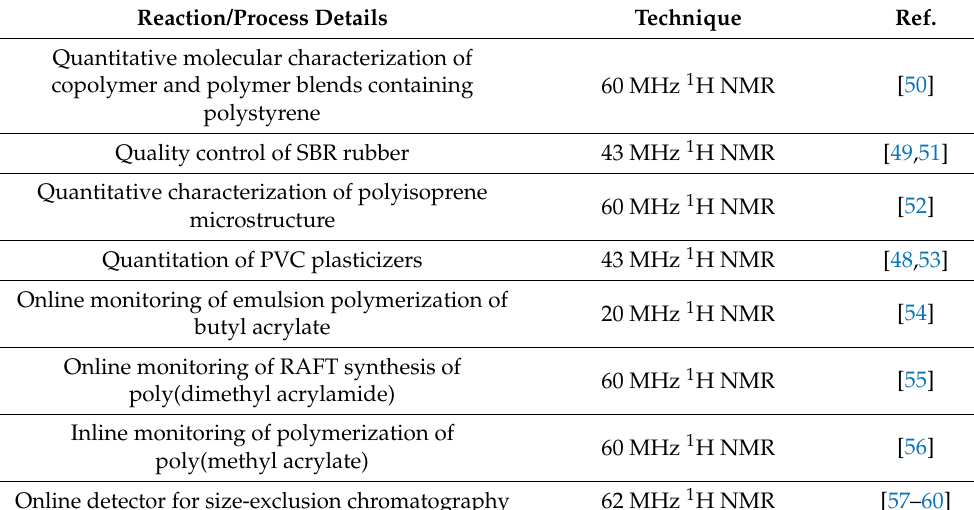
Table 3. Applications of benchtop NMR spectroscopy in the field of polymers. Reaction/Process